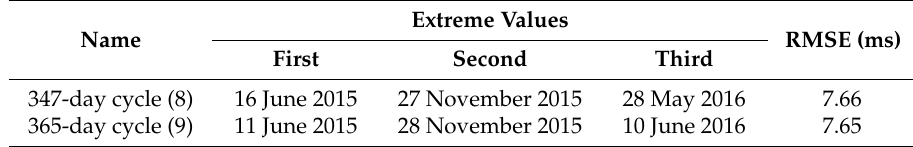
Table 3. Extreme values and the days between the first and the third extreme values (peak-to-peak).